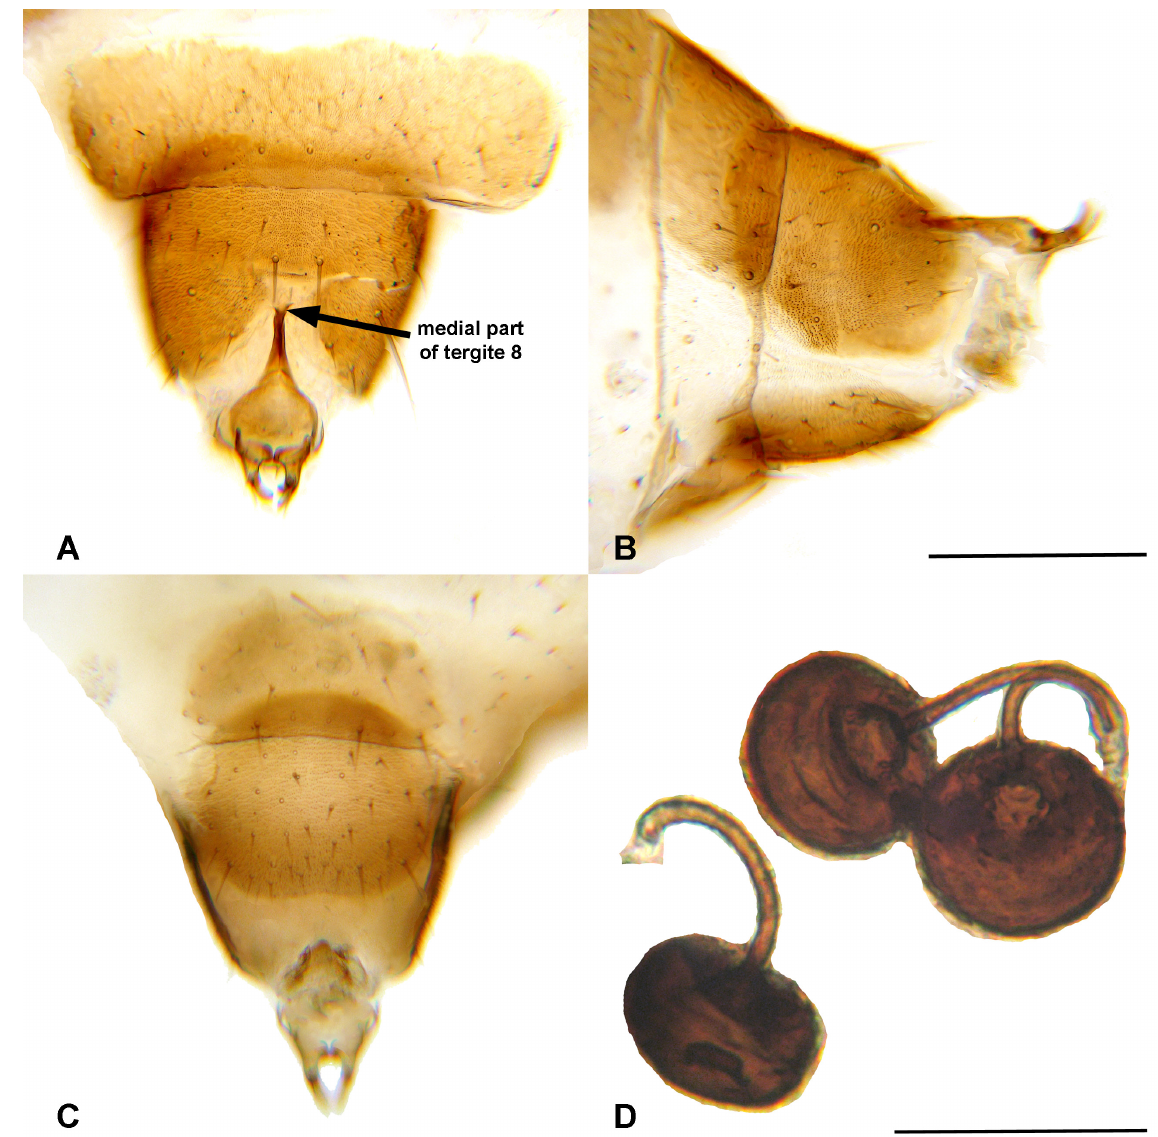
Fig. 20 . Rudolfina remiforma sp. nov., female terminalia (debu01086288). A . Terminal abdominal segments, dorsal view. B . Same as preceding, lateral view. C . Same as preceding, ventral view. D . Spermathecae. Scale bars: A–C = 0.15 mm; D = 0.05